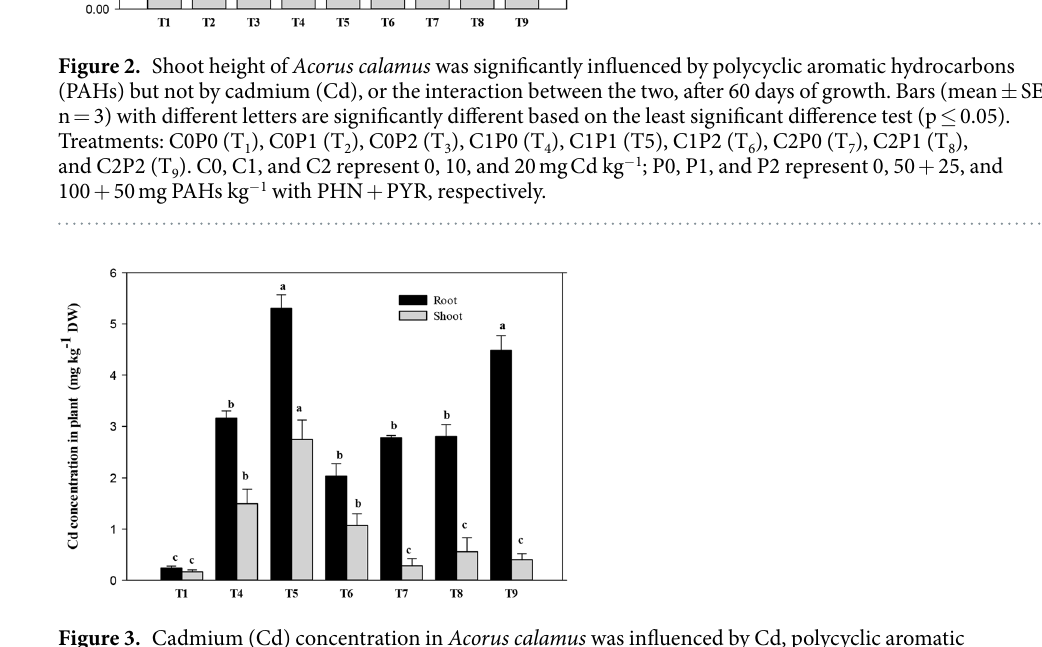
Figure 3. Cadmium (Cd) concentration in Acorus calamus was influenced by Cd, polycyclic aromatic hydrocarbons (PAHs), and the interaction between the two (p < 0.001) after 60 days of growth. Bars (mean ± SE, n = 3) with different letters (a,b,c) are significantly different based on the least significant difference test (p < 0.05). Treatments: C0P0 (T 1 ), C1P0 (T 4 ), C1P1 (T 5 ), C1P2 (T 6 ), C2P0 (T 7 ), C2P1 (T 8 ), and C2P2 (T 9 ). C0, C1, and C2 represent 0, 10, and 20 mg Cd kg − 1 ; P0, P1, and P2 represent 0, 50 + 25, and 100 + 50 mg PAHs kg − 1 with PHN + PYR,